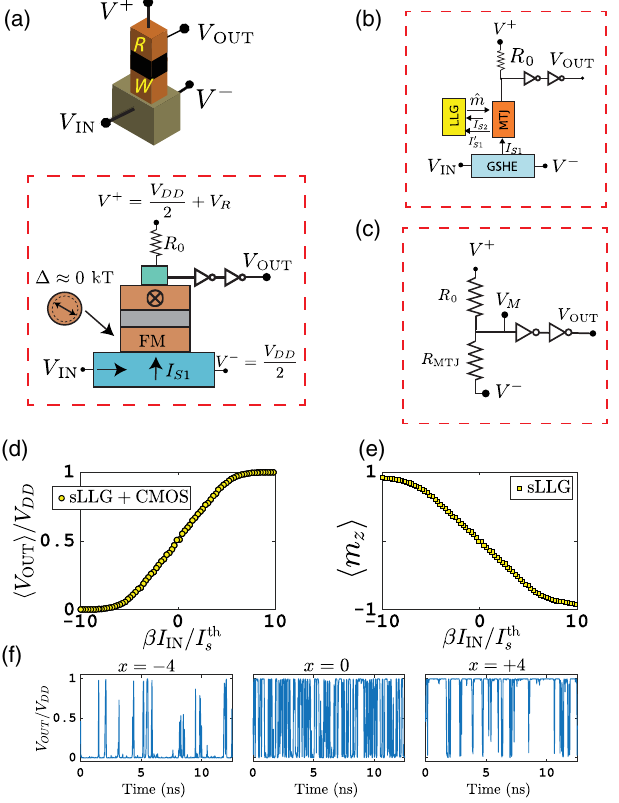
FIG. 3. CMOS-assisted implementation of p -bits. (a) A possible CMOS-assistedimplementationof p -bitsthathaveseparateREAD- WRITE paths. A GSHE layer provides a spin current is able to pin the magnetization of circular ferromagnets (FM) ( Δ ≈ 0 kT). The change in magnetization is sensed by a MTJ and amplified by two CMOS inverters that act as a buffer, providing the necessary isolation and gain. (b) Self-consistent, modular modeling of trans- port and magnetization dynamics. See “ Assumptions of the model ” in the text. (c) Equivalent READ circuit. (d) SPICE -based average output voltage normalized to the V DD ¼ 0 . 8 V of 14-nm Fin Field- Effect Transistor (FinFET) high-performance (HP) inverters [44]. (e) sLLG-based average magnetization of the circular magnet as a functionofthespincurrent(averagedover500nsforeachbiaspoint with a time step of Δ t ¼ 0 . 05 ps, 10 × 10 6 points per marker), normalized to the GSHE gain and the thermal noise strength I th s . (f) The time-dependent output voltage at various bias points. FIG. 4. Invertible AND gate. (a) Passive resistor network that the GSHE ground V − ¼ V DD = 2 simply shifts all the is used to obtain the connection terms J ij to correlate p -bits. voltages to get symmetric (cid:3) swings, we define the voltages The output impedance R ij ¼ 1 =G ij is much smaller than the input ð V 0 Þ i ¼ ð V Þ i − V − . Then input currents to each OUT OUT impedance R , allowing separate voltages to add at the input of p -bit can be expressed [Fig. 4(a)]: GSHE the i th p -bit. (b) Explicit implementation of an AND gate based on Eq. (10). (c) When C is clamped to 1, A and B spend most of their time in the (11) state, the only combination consistent with C ¼ 1 . (d) The invertible operation of the AND gate when the C gate is clamped to a zero, while A and B are left floating. A and B bits fluctuate between three possible combinations consistent with assuming j G ij ≪ G , since the heavy metal resis- GSHE C ¼ 0 , ð A; B Þ ¼ ð 00 Þ ; ð 01 Þ ; ð 10 Þ . The time response of A , B , C tances are typically much less than hundreds of k Ω . We voltages are normalized by V DD . Histogram is obtained by verify the validity of Eq. (9) by SPICE simulations, for the averaging over 200 ns of thresholded voltages, only the first parameters chosen for these examples. 20 ns of A , B , C voltages are shown for